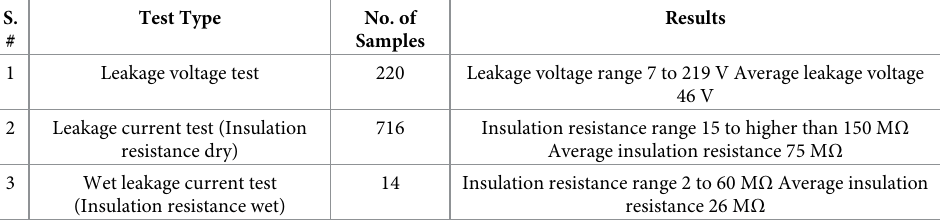
Table 3. Summary of test results.